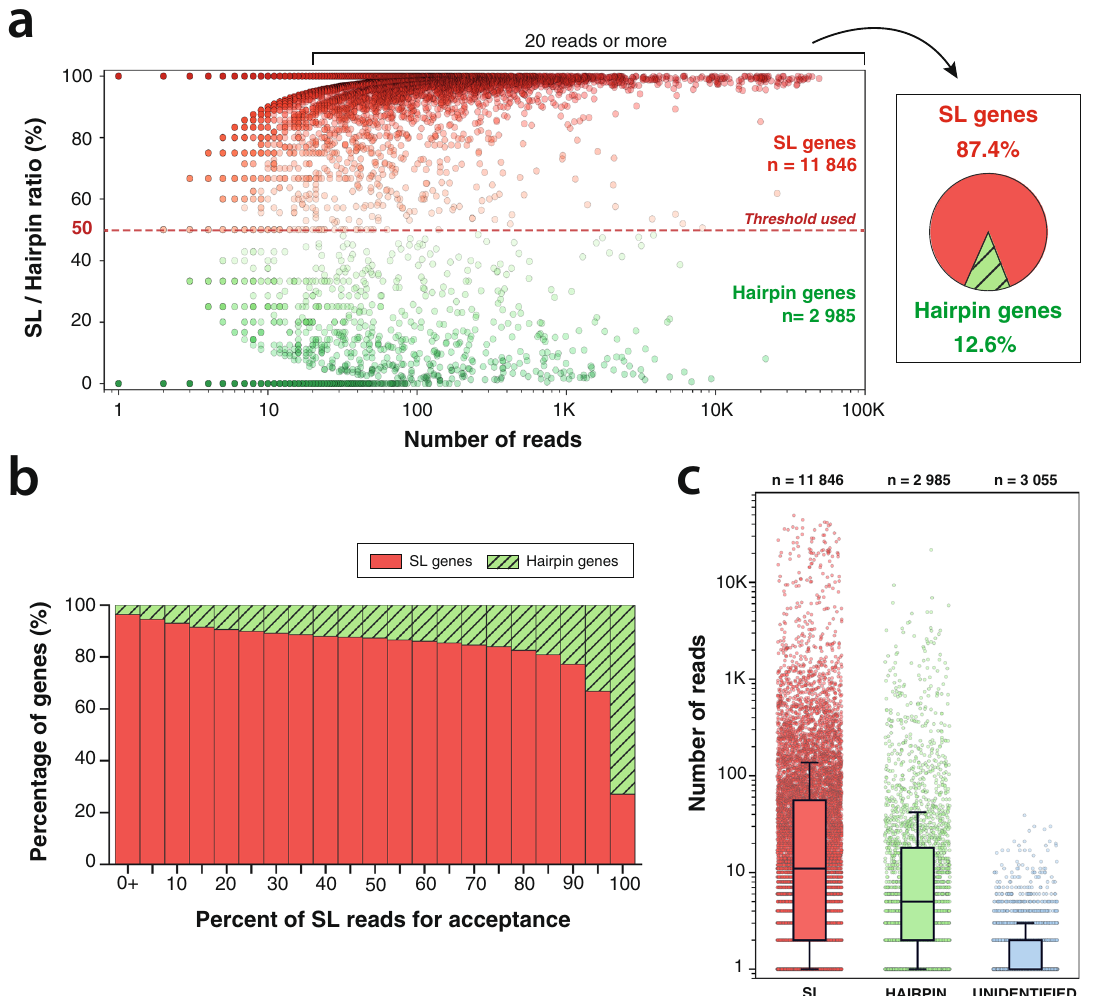
Fig. 5 | Quantitative analysis of trans -splicing prevalence. a For each gene, we measured the ratio of SL/Hairpin reads at the most expressed starting mRNA position. For genes with at least 20 reads at their most expressed position, we representtheproportionofgenesthathaveamajorityofSLreads. b Proportionof trans -spliced gene with various SL thresholds. c Read coverage for genes